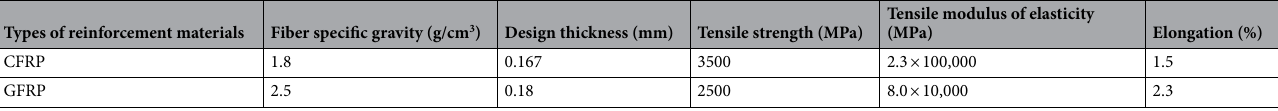
Table 1. Reinforcing material performance